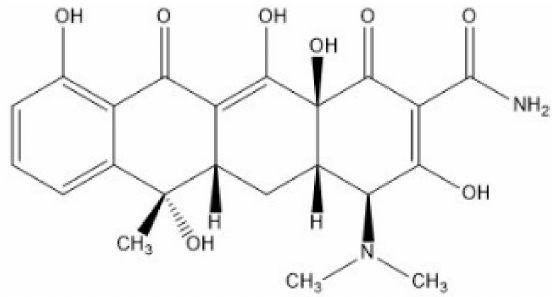
Figure 2. The chemical structure of